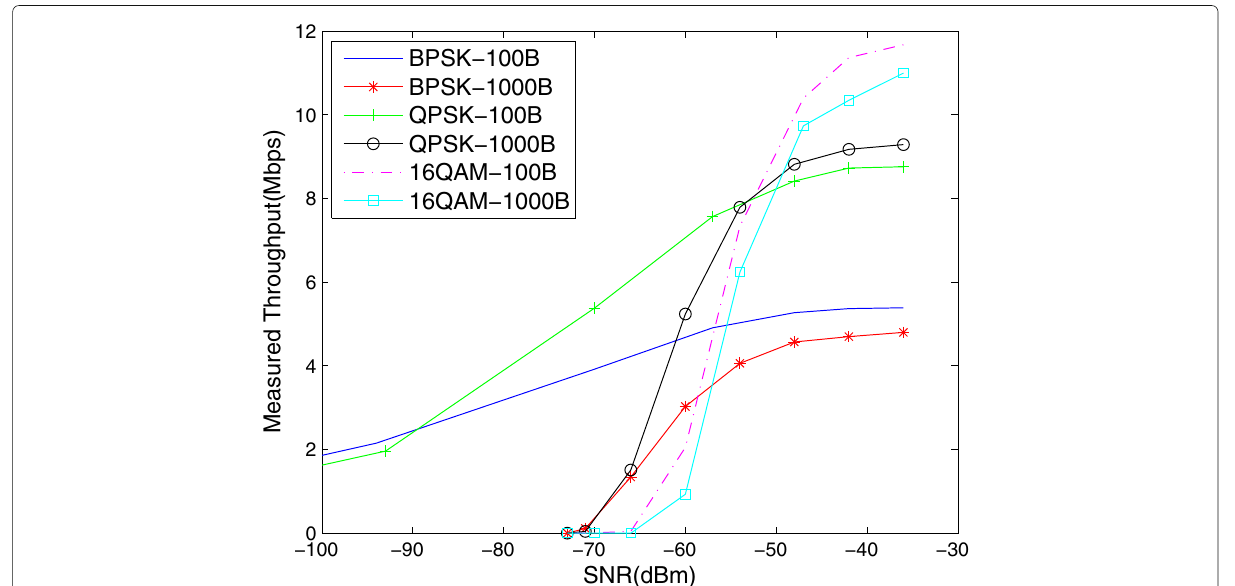
Fig. 1 Performance of different modes in WARP. The throughput performance for different modulation schemes and packet sizes on a 4-tap channel with a velocity of